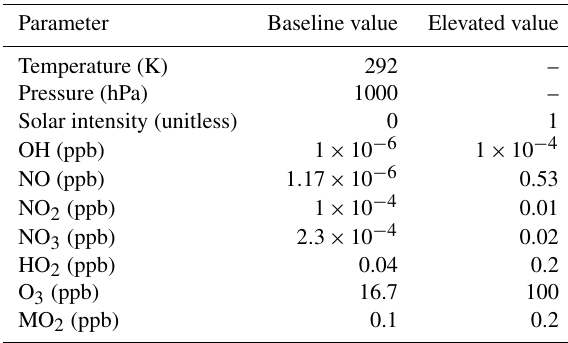
Table 2. Baseline and elevated values of input parameters used in the pathway importance algorithm, a component of the AMORE